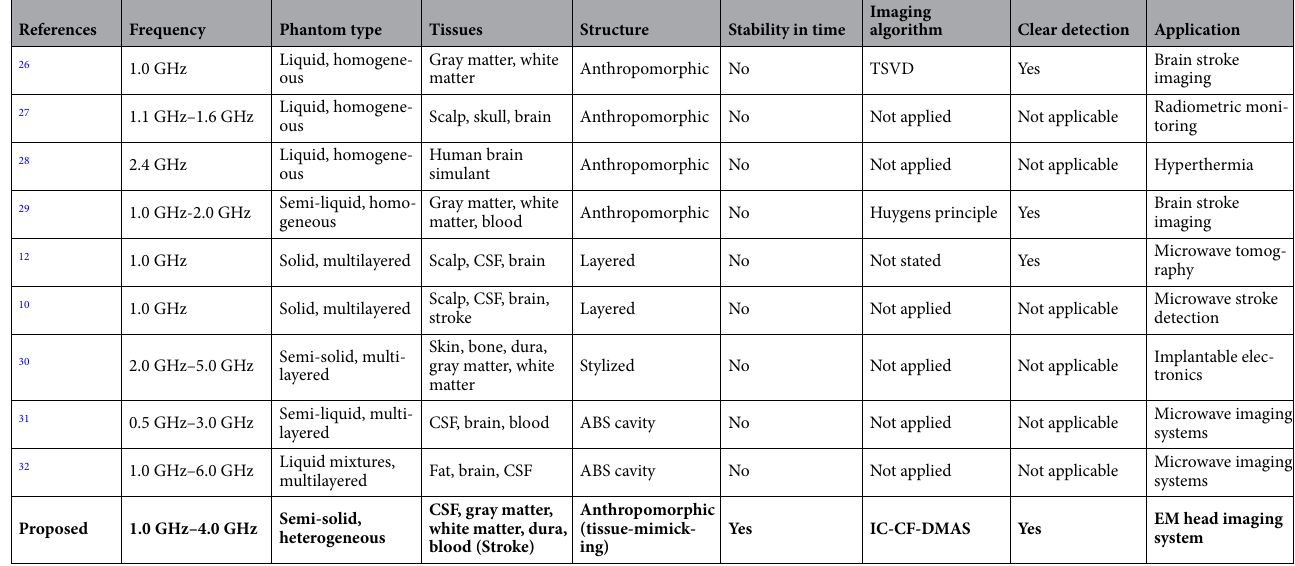
Table 4. Comparison of developed tissue-mimicking head phantom with existing phantoms and detection capabilities. The bold in Table 4 is to highlight the properties of the proposed analysis compared to existing